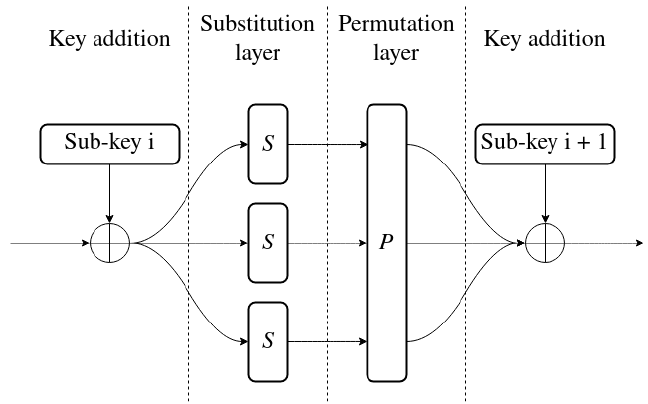
Figure 3. Full round of